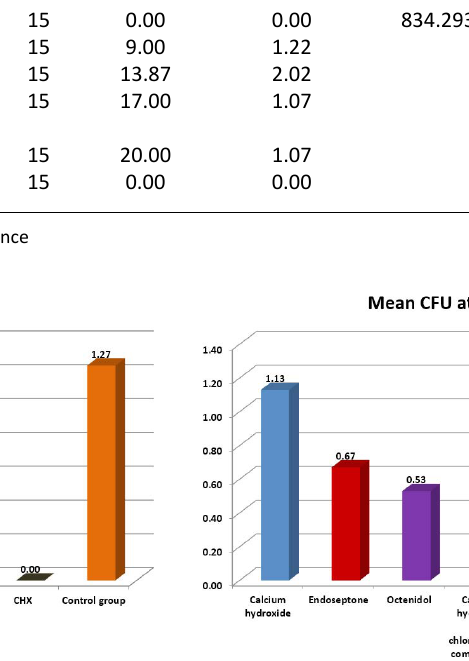
Zone of inhibition at 72 hours Number Mean Std. Deviation